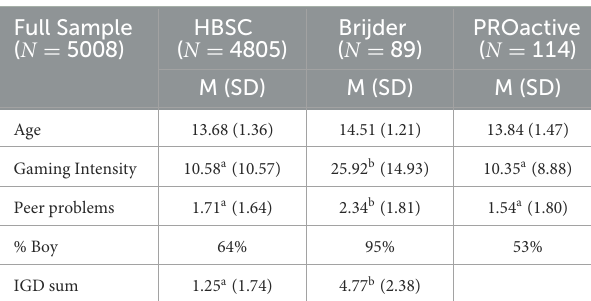
TABLE 1 Descriptive statistics of the PROactive, HBSC, and Brijder